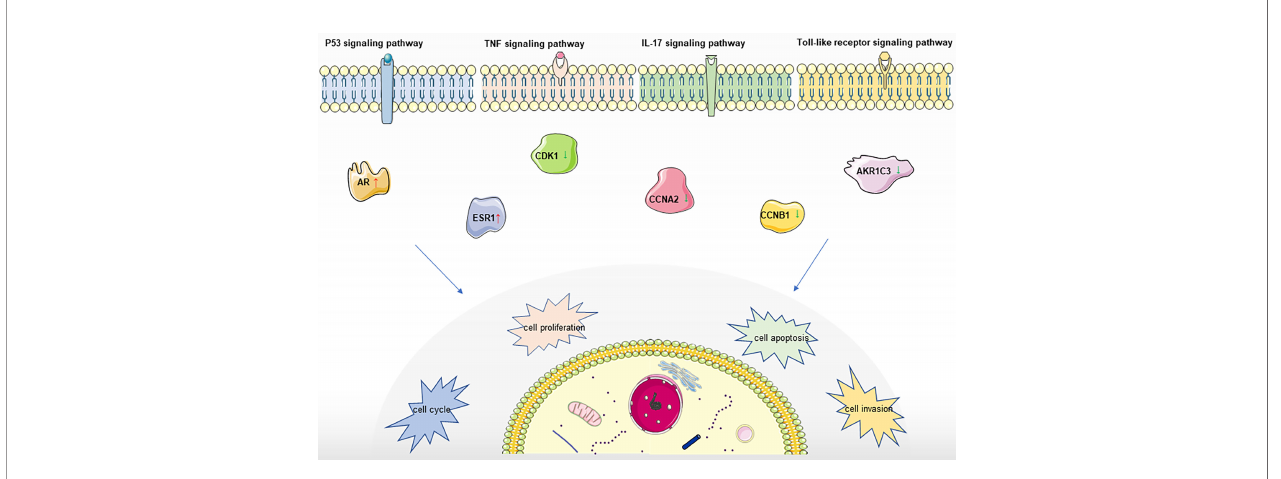
FIGURE 6 | Mechanism of PADP in the treatment of